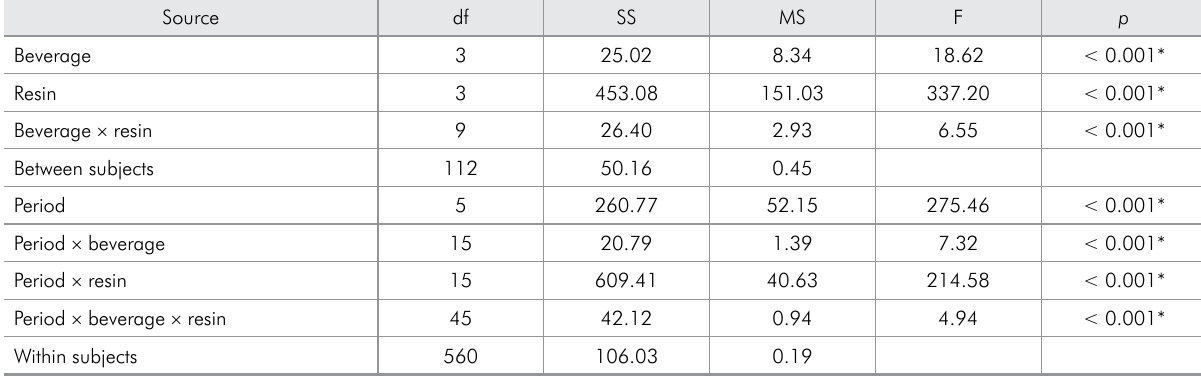
Table 5 - Three-way repeated-measures analysis of variance of the color changes of acrylic resins in beverages. Source df